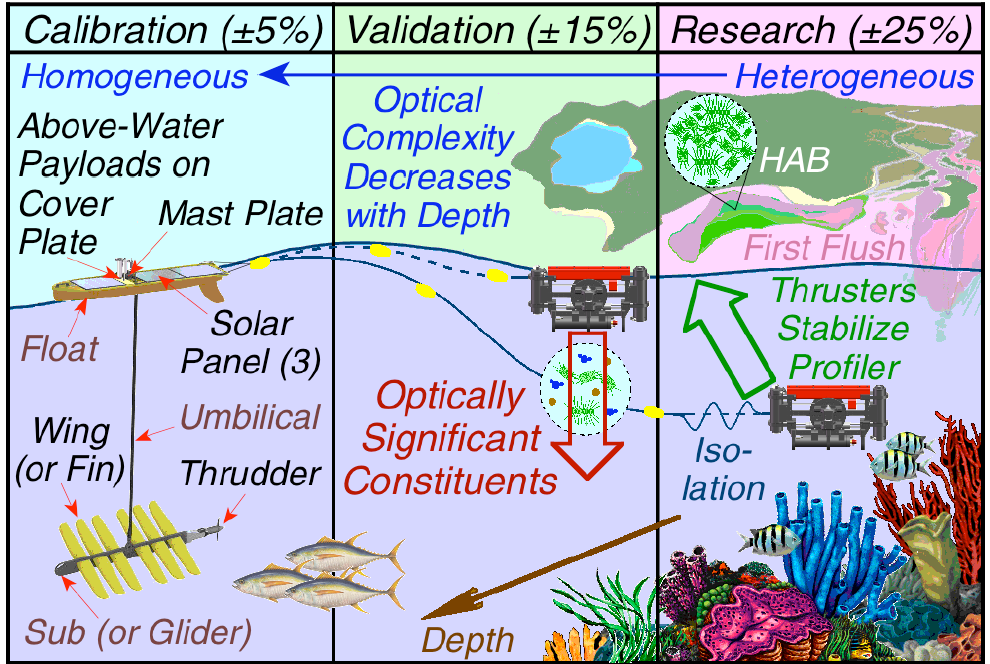
Figure 1. A schematic showing use of an SV3 in calibration, validation, and research (CVR) sam- pling activities, wherein notional uncertainty thresholds (in percent) decrease as optical complexity decreases with increasing water depth. Decline in optical complexity follows transition from hetero- geneous and frequently eutrophic near-shore waters to the homogeneous and typically oligotrophic open ocean. The inland lake in the figure can span all productivity and complexity levels. Notional uncertainties are adopted from the Protocols and next-generation mission planning [3]. Example maximum optical complexity is shown for a first-flush plume and associated harmful algal bloom (HAB). Yellow cylinders on the sea cable represent rigid and hydrobaric buoyancy devices to con- trol drag properties and an isolation segment smooths towing forces acting on the sea cable. The schematic is not to scale to emphasize the low profile of the SV3 and details of the